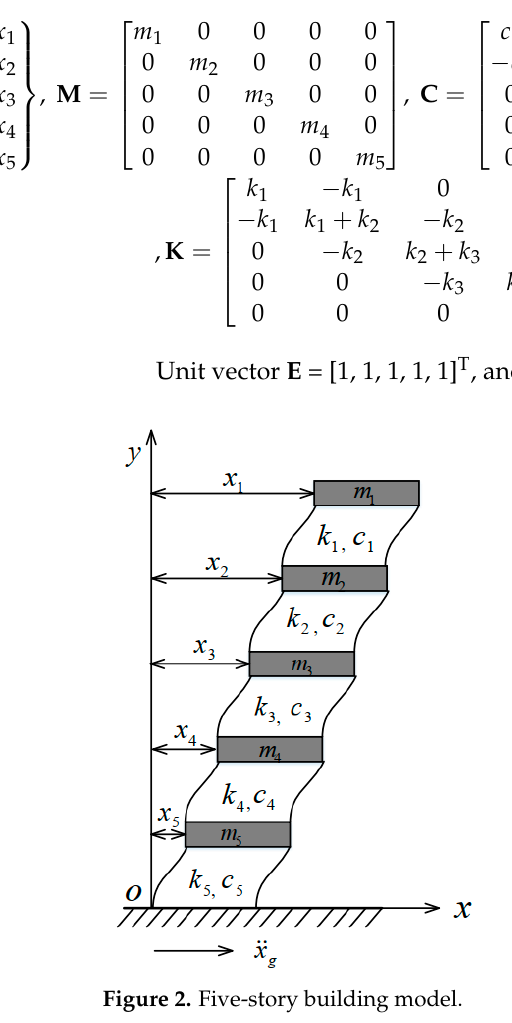
Figure 2. Five-story building model.